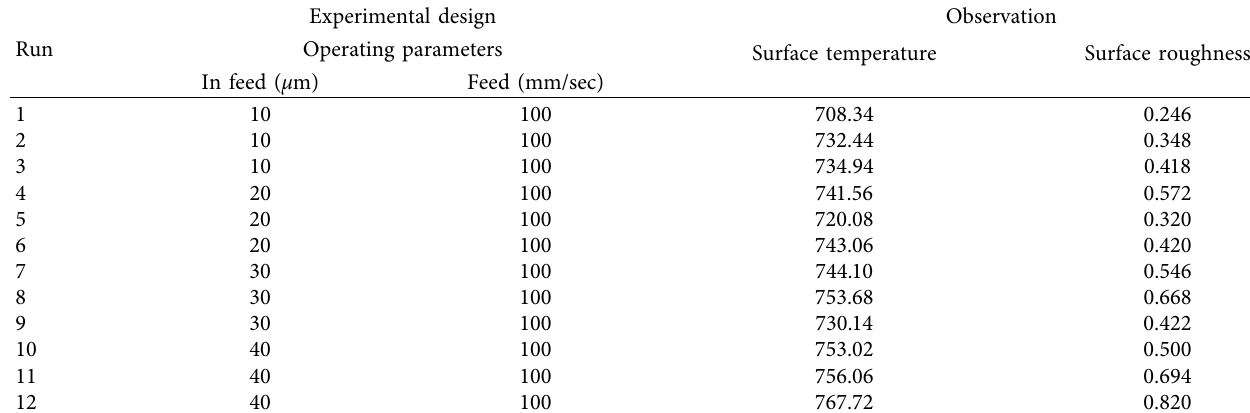
Table 5: Taguchi full factorial design: dry machining environment.